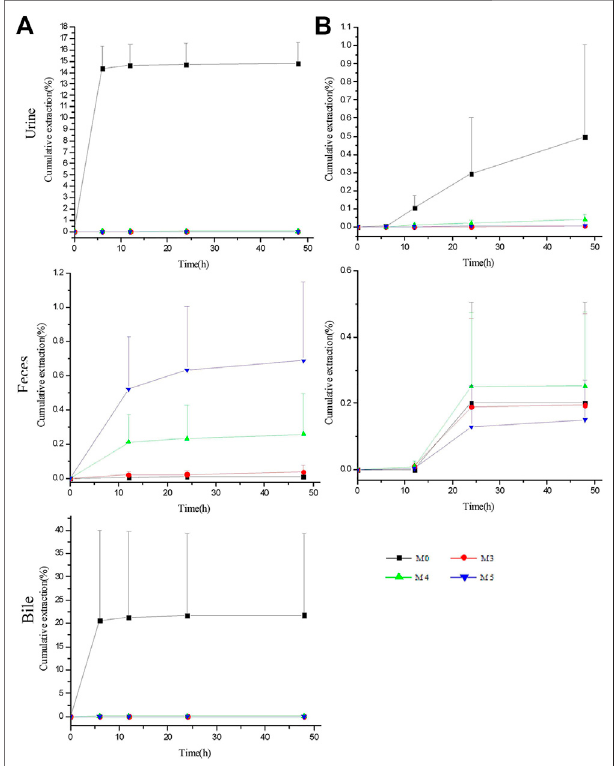
FIGURE6| Biliary,urinaryandfecalcumulativeexcretionpro fi lesofASD and its metabolites after intravenous (A) and intragastrical (B) administration ( n (cid:2)